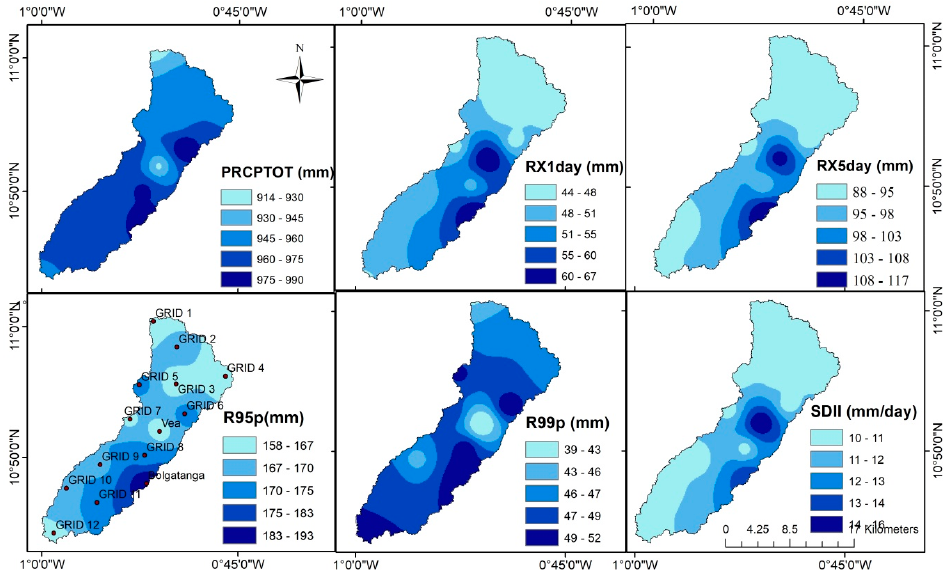
Figure 4. Spatial distribution of annual extreme rainfall intensity Indices.